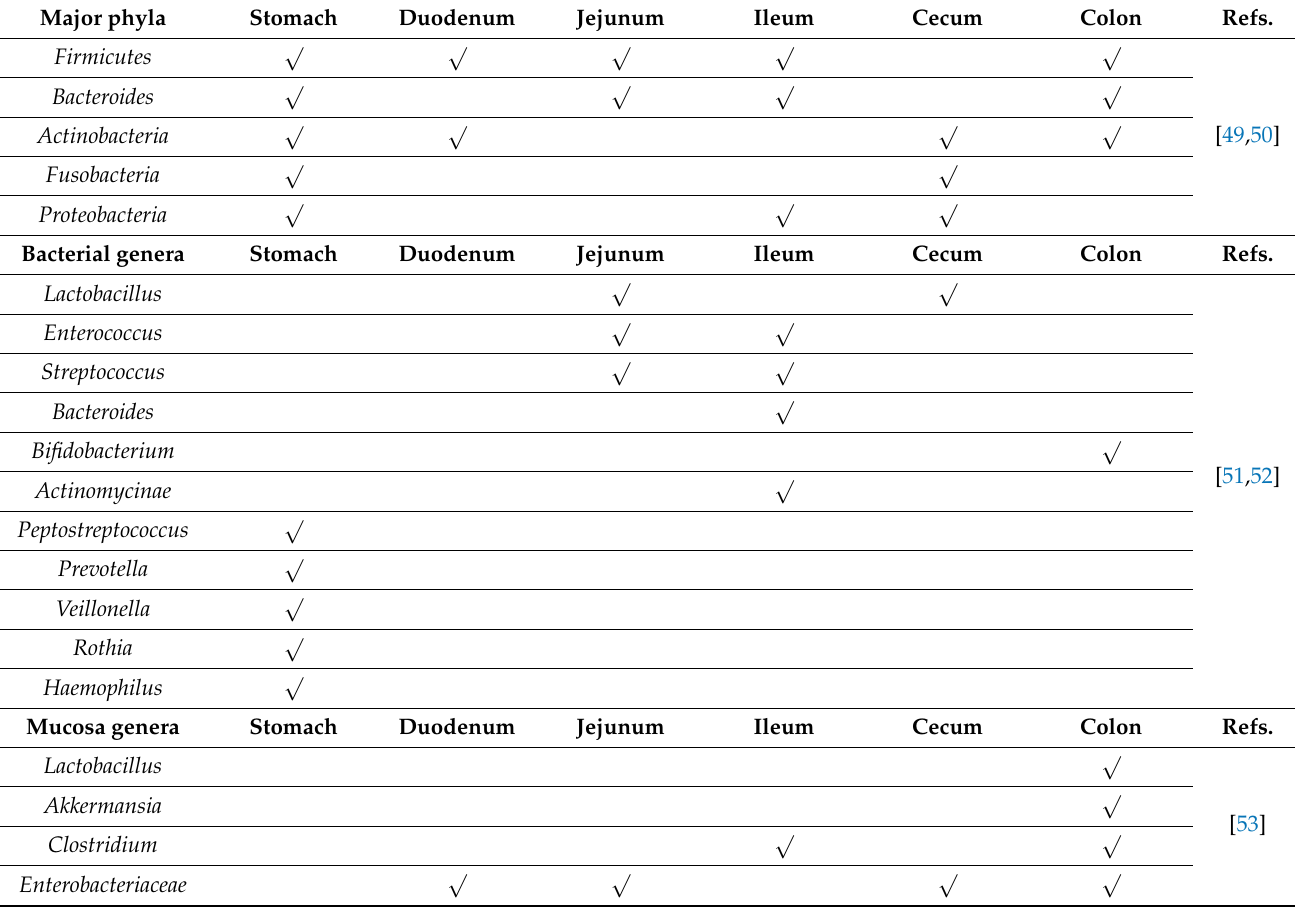
Table 1. Bacteria phyla and genera in the GI